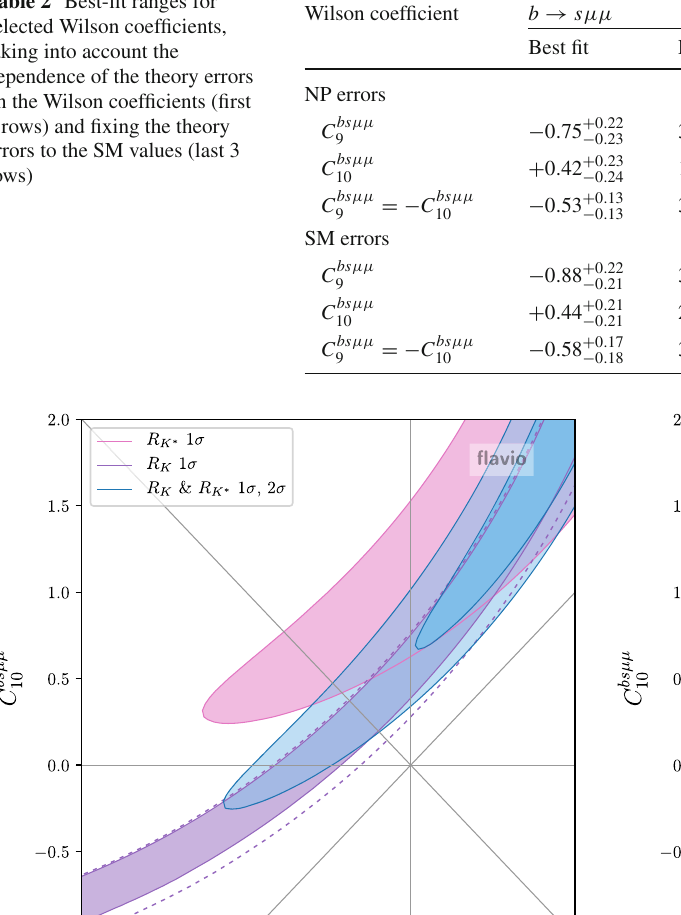
Table 2 Best-fit ranges for selected Wilson coefficients, taking into account the dependence of the theory errors on the Wilson coefficients (first 3 rows) and fixing the theory errors to the SM values (last 3